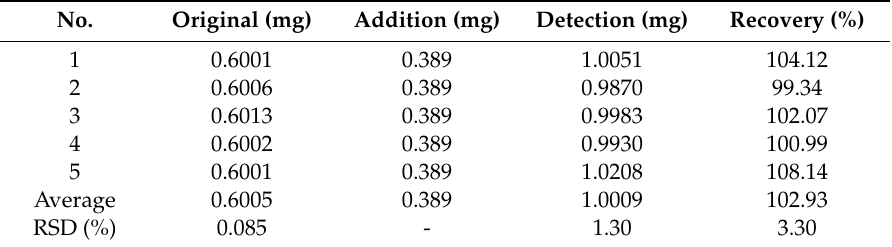
Table 3. Analysis of the recovery of complanatuside (n = 5).